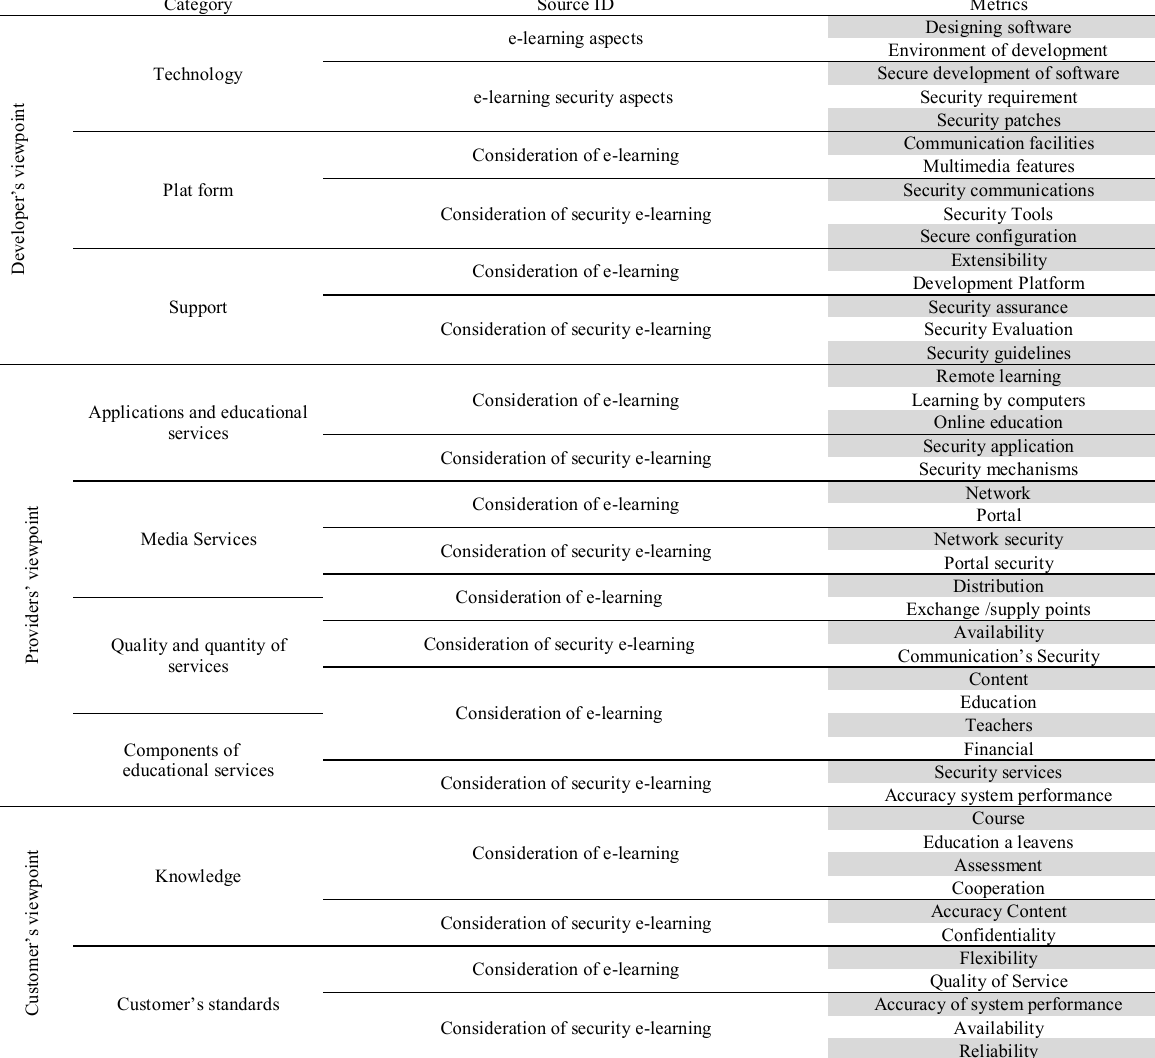
The results of the data analysis of